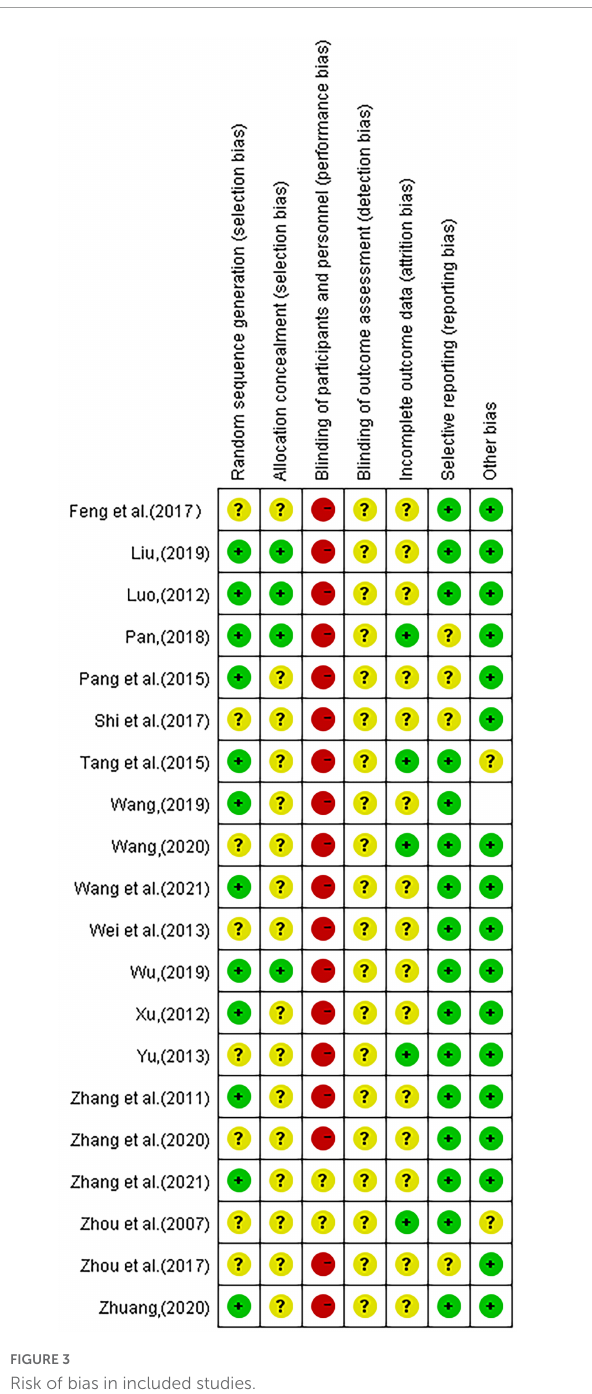
FIGURE3 Risk of bias in included